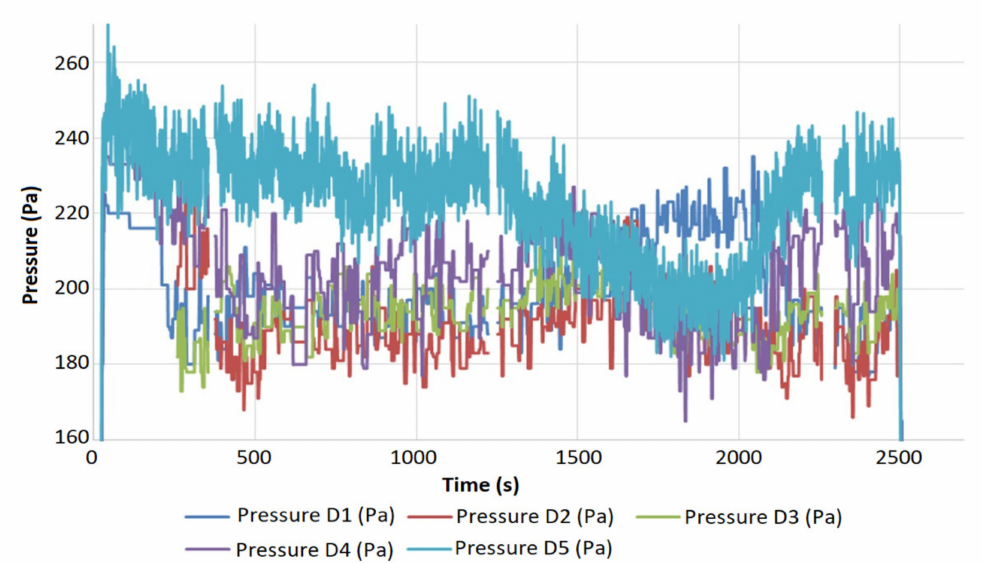
Figure 11. Measured dynamic pressures during the first and second tests. Table 1 shows data collected by the measuring devices during the tests. The data are divided into columns depending on the leak location. The markers (according to connector numbering in Figure 8 from T1 to T5 (static pressures) mark successive measuring devices and the results of pressure measurements before and after unsealing. Table 1. Static pressure and static pressure differences noted during unsealing and sealing of the system (I test). Test I Leak between T1-T2 Leak between T2-T3 Leak between T3-T4 Leak between